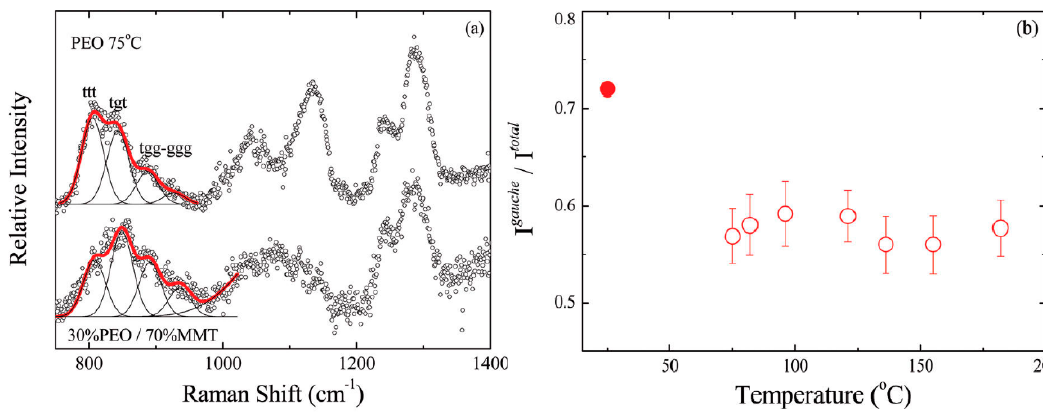
Figure 4. ( a ) Raman spectra at 75 °C of neat PEO and a 30 wt % PEO/70 wt % sodium-activated montmorillonite (Na + -MMT) nanocomposite at ambient temperature and their fit with four Gaussians in the spectral region of CH 2 rocking vibrations; ( b ) Ratio of integrated intensity of the bands that correspond to gauche conformation to the total integrated intensity in the spectral region of CH 2 rocking vibration. PEO ( open circles ); 30 wt % PEO/Na + –MMT ( filled circles ). Reproduced with permission from Chrissopoulou et al. [62]. Copyright 2011, American Chemical Society.